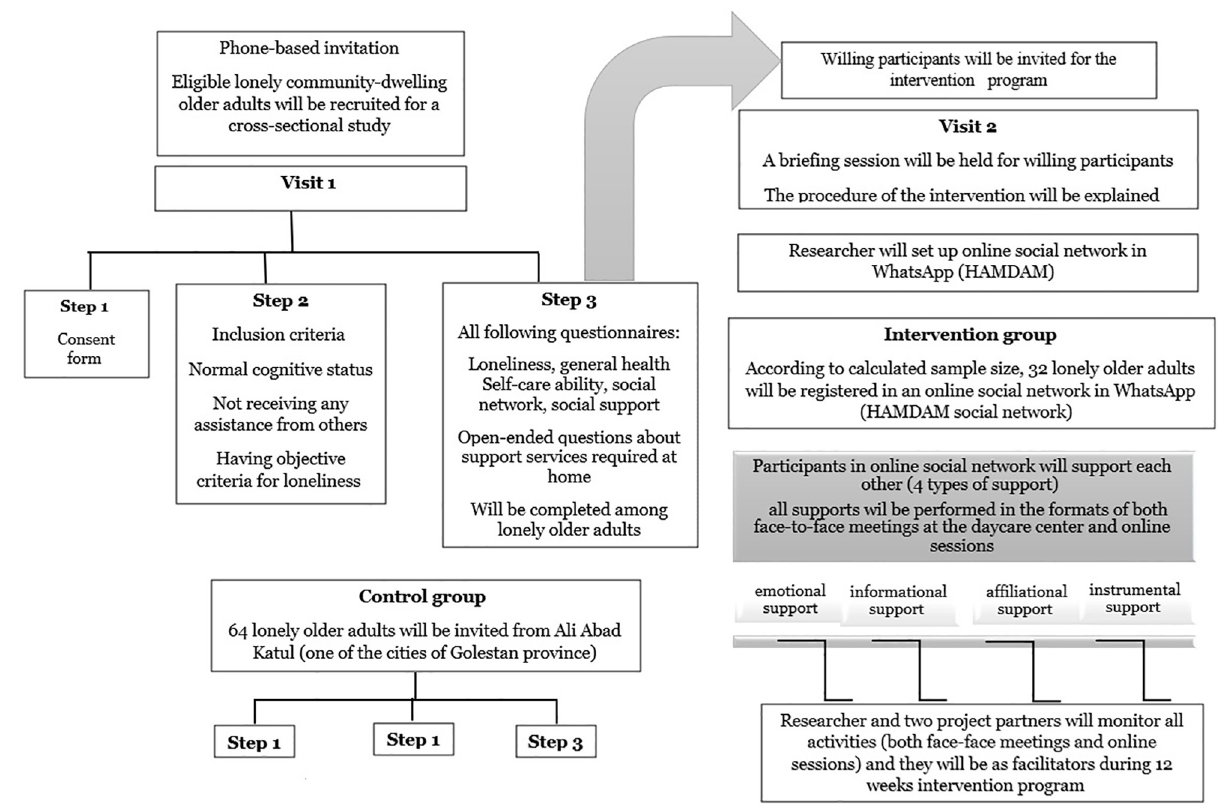
Fig 2. The chart of the intervention